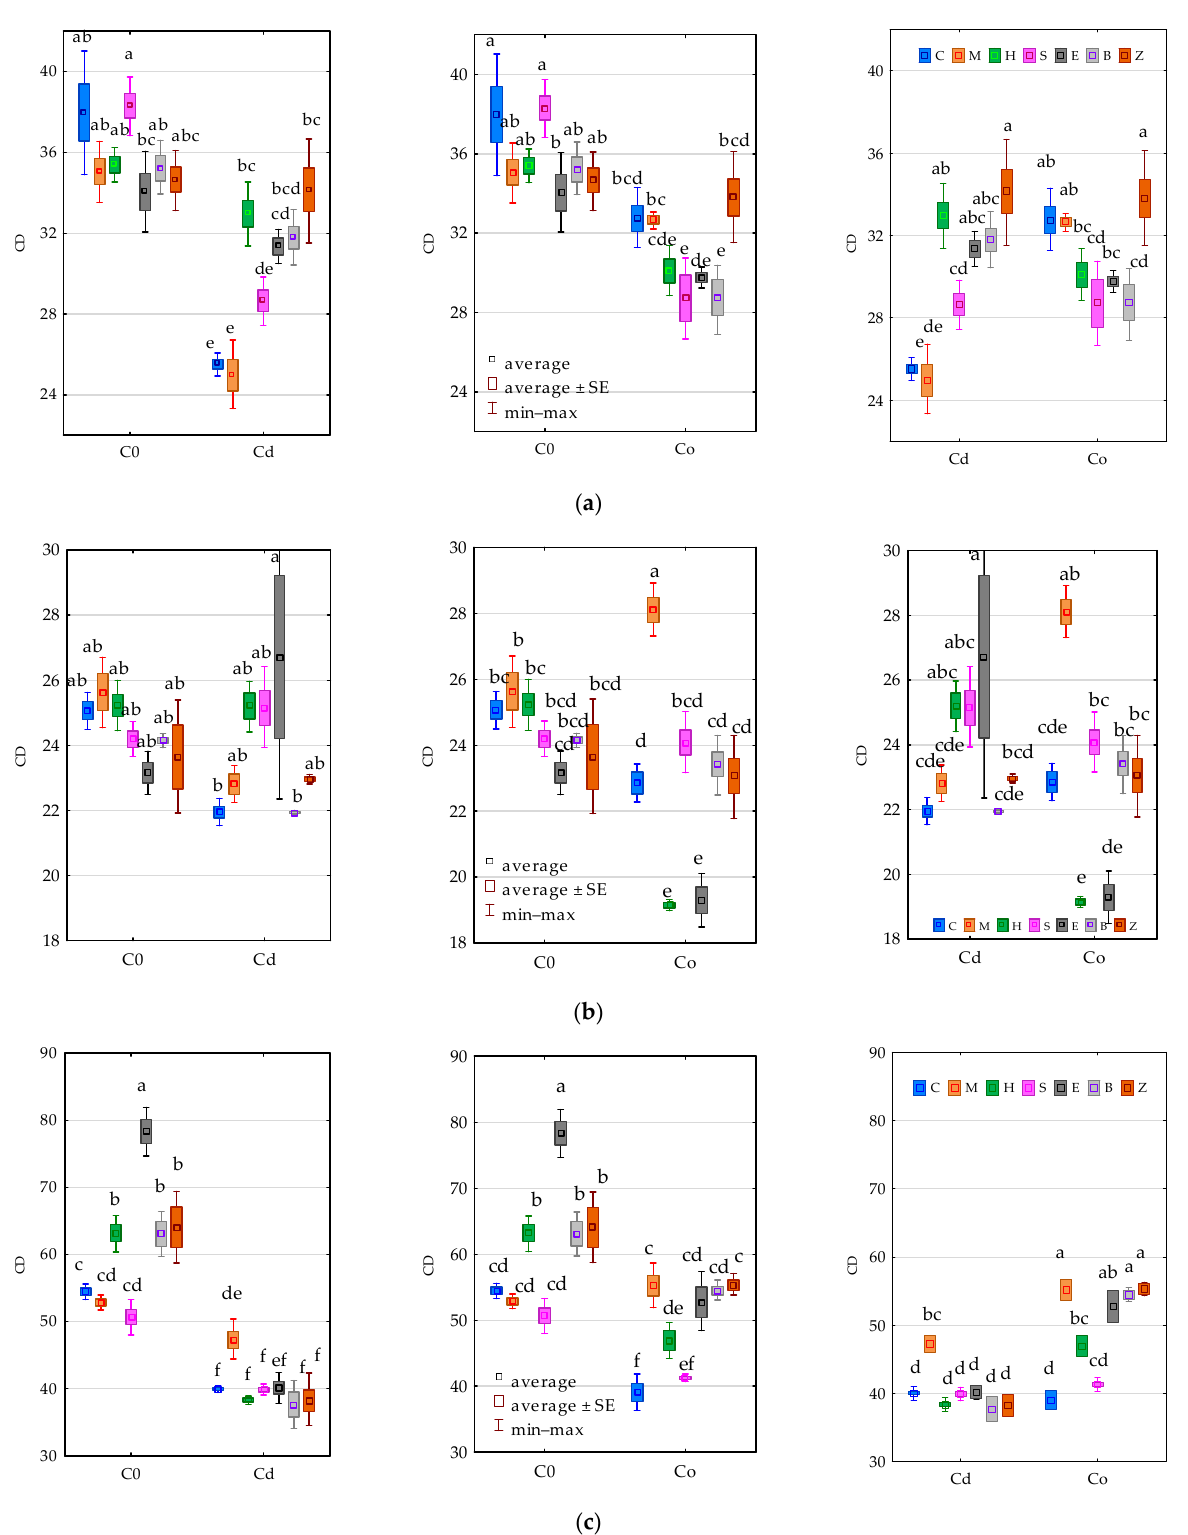
Figure 2. Effect of soil contamination with cadmium (Cd 2+ ) and cobalt (Co 2+ ) on the colony development index (CD) of ( a ) organotrophic bacteria (Org), ( b ) actinomycetes (Act) and ( c ) fungi (Fun). C0—uncontaminated soil, Cd—cadmium ion, Co—cobalt ion. C—control, M—molecular sieve, H—halloysite, S—sepiolite, E—expanded clay, B—biochar, Z—zeolite. Homogeneous groups denoted with letters (a–f) were calculated separately for each pair of independent